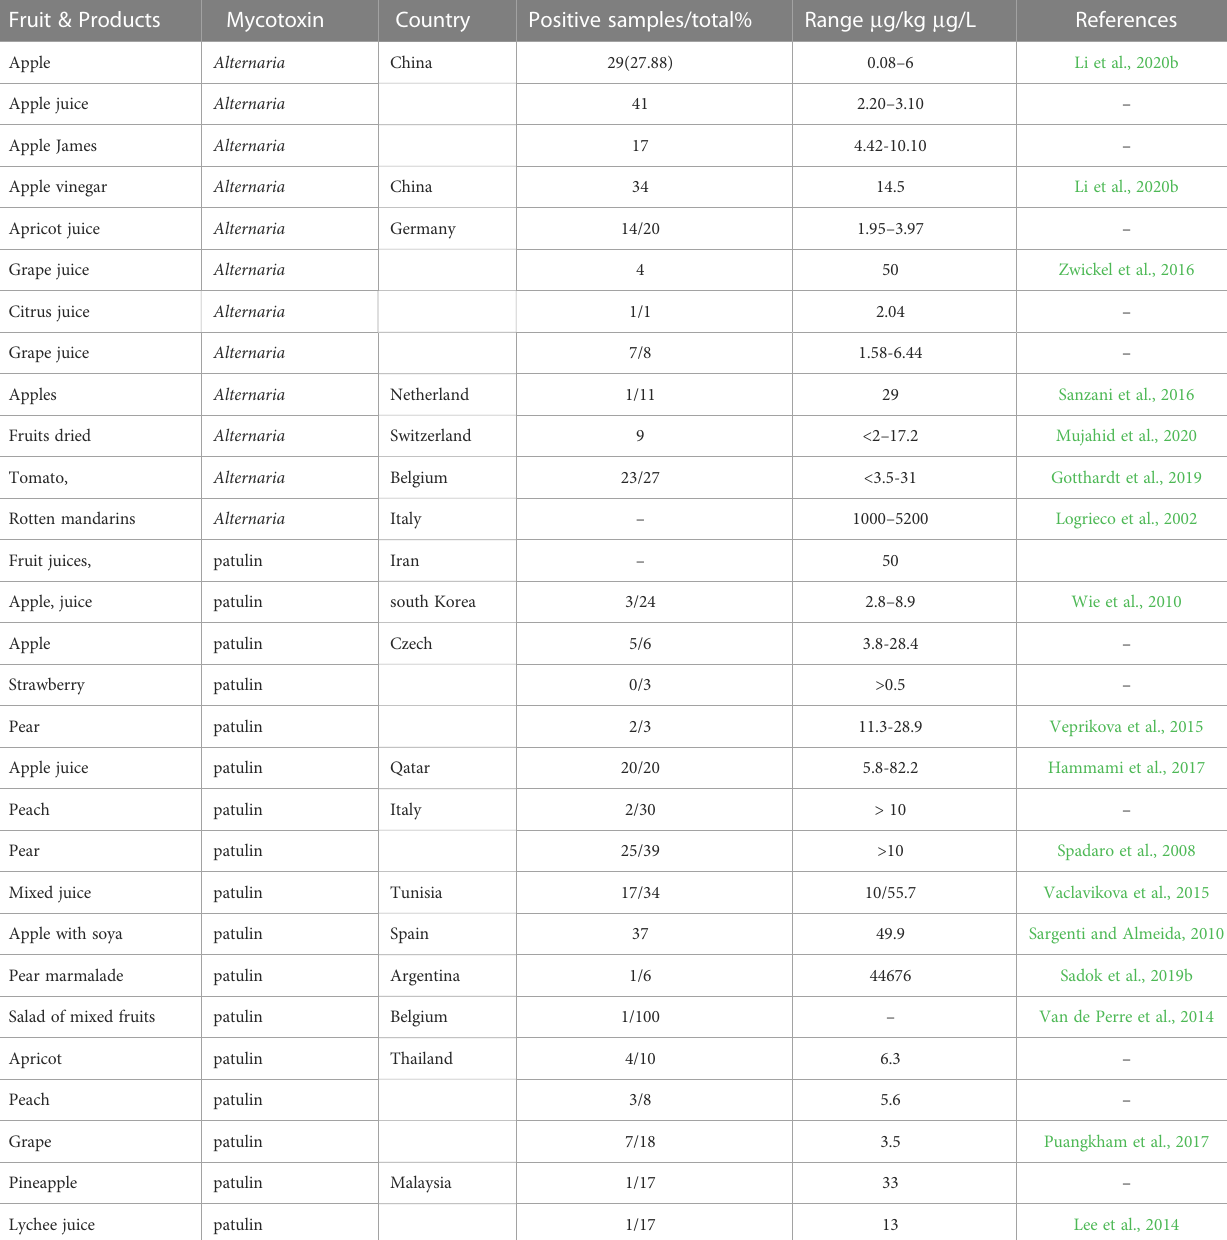
TABLE 1 Worldwide natural occurrence of Alternaria and patulin mycotoxins in fruits and derived